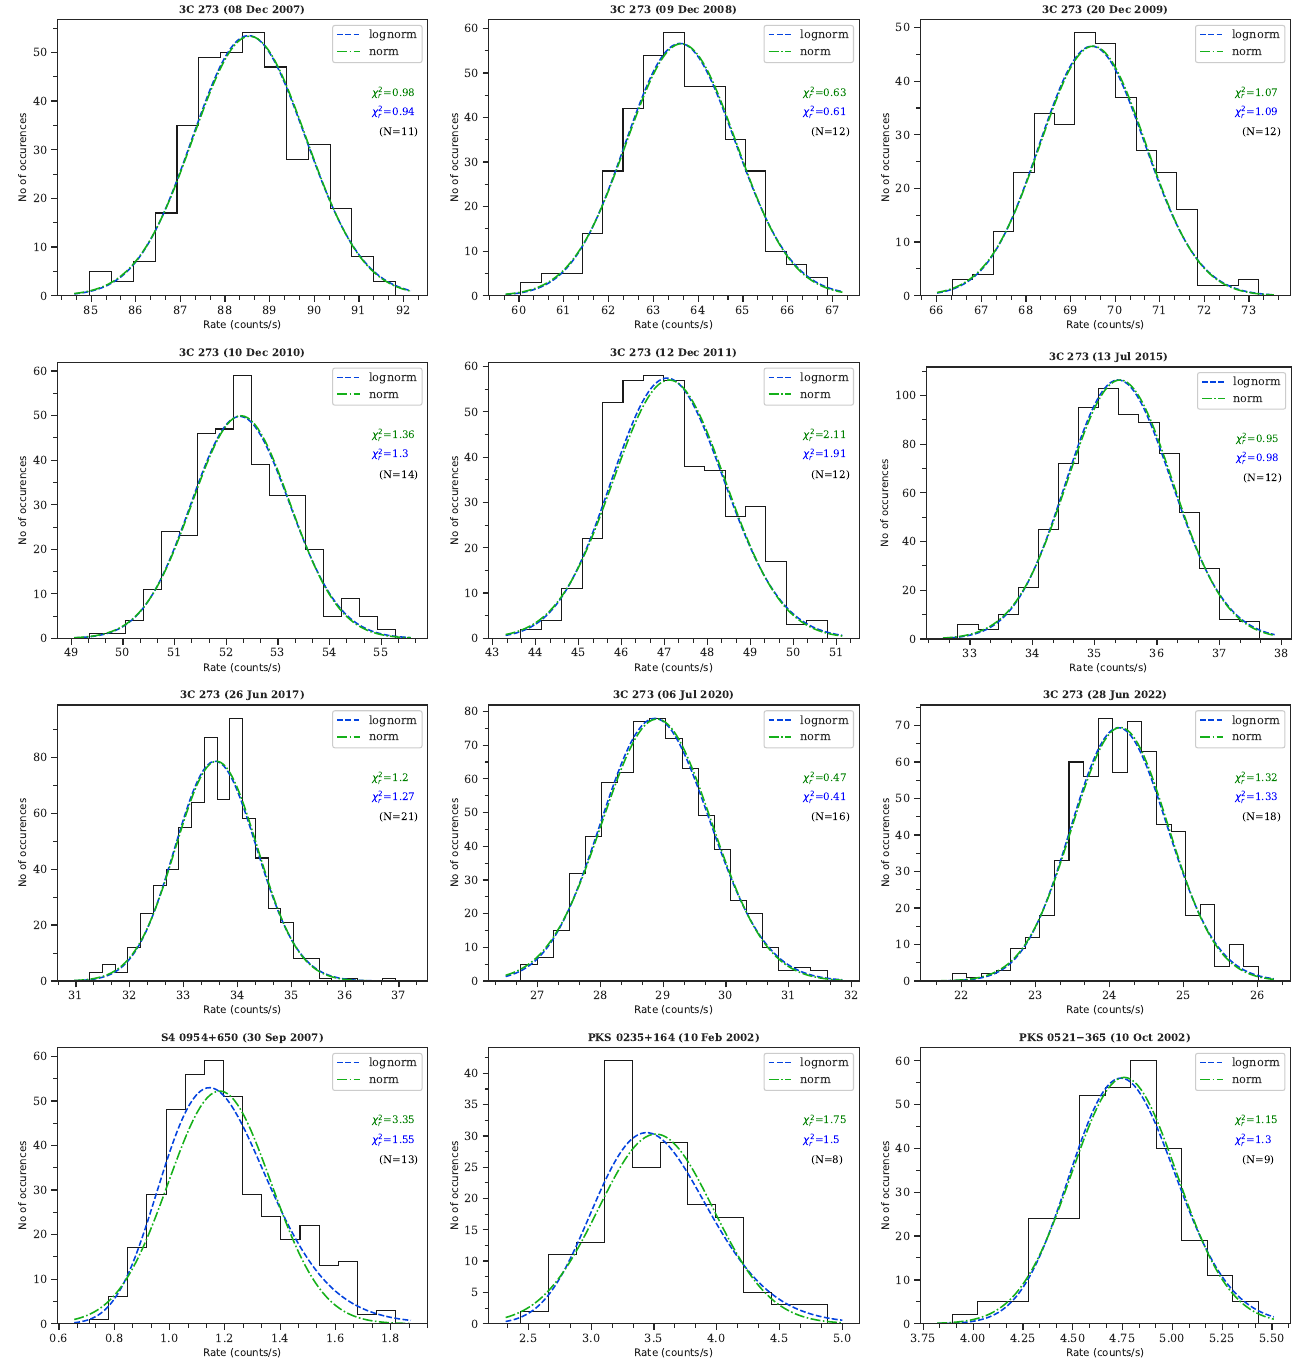
Figure 2. Histogram of count rate of light curves of XMM-Newton observations of blazars. Blue dashed lines represent lognormal and green dash-dotted lines represent normal PDF fitting results. N represents the degree of freedom of observational